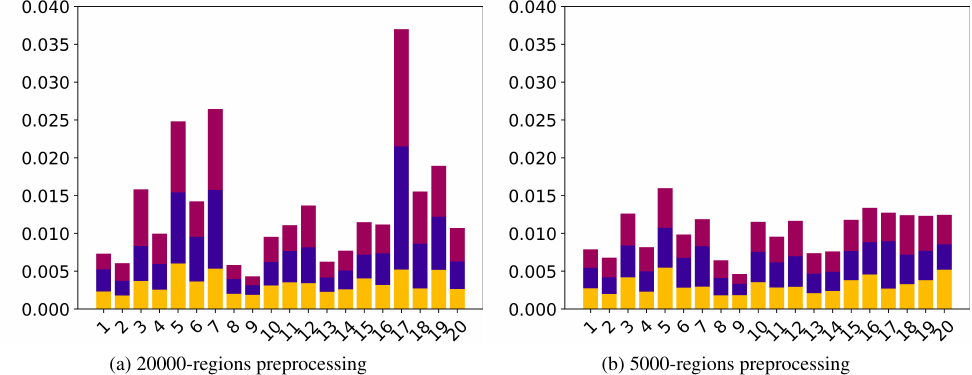
Figure 5. Proportion of added pixels for Coreset at steps 5, 10 and 15.